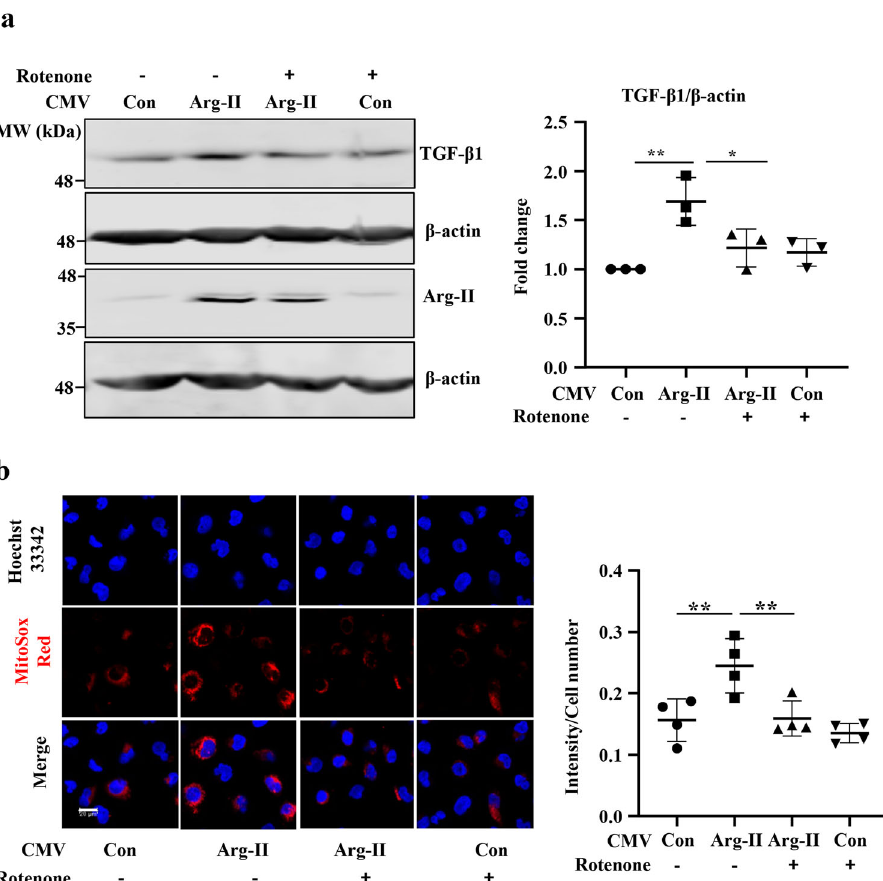
for TGF- β 1, Arg-II, and β -actin. The graph on the right shows the quanti fi cation of the signals on immunoblots. n = 3. b Cells were subjected to mitochondrial superoxide detection with MitoSox (red), followed by nuclei staining with Hoechst 33342 (blue). The images were taken